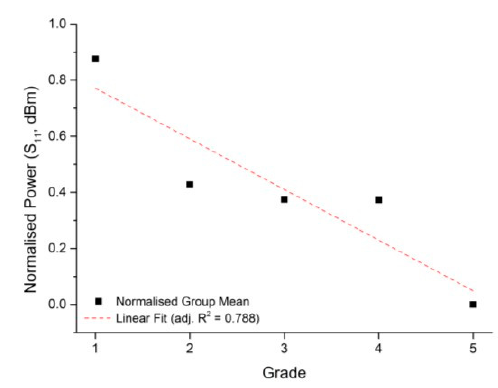
Figure 5. Correlation between strawberry grade (1–5) and sensor signal in the 200–600 MHz